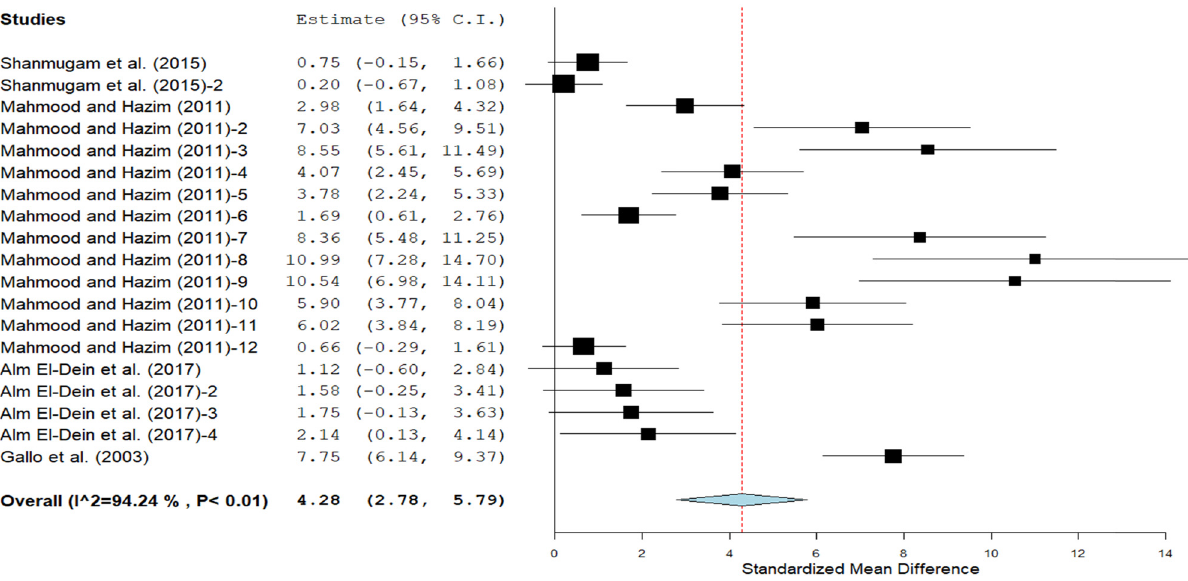
Figure 4: In fl uence of dietary zinc additive on sperm concentration. The thick vertical line is the line of no e ff ect ( i.e. SMD = 0 ) . Points to the left of this thick vertical line connote a decrease in sperm concentration, while points to the right depict an increase in sperm concentration. The dotted line shows the overall SMD. The result is considered signi fi cant the 95% CI of the overall SMD did not include zero.